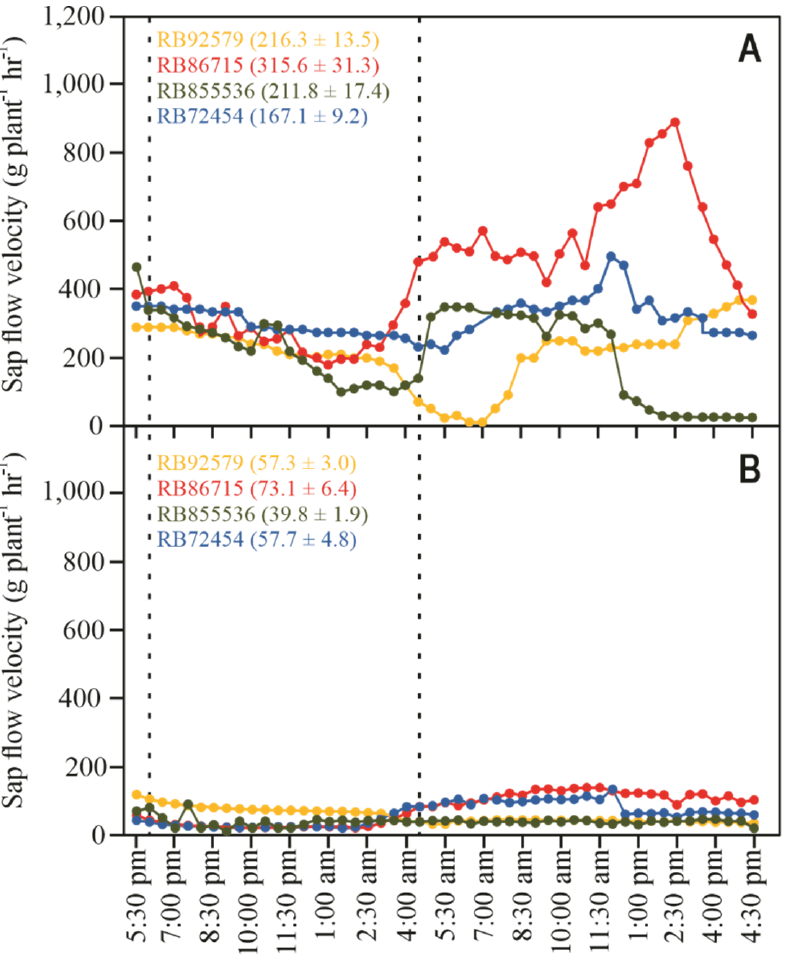
Figure 5. Motive force that drives sap ascent in the xylem (SAP flow velocity) measured over 24 h in open field cultivated sugarcane plants. Each point represents a measurement and the values, in parentheses, represent the average SAP over 24 h (for comparison purposes only), with 49 readings per plant, measured every 30 min. The period of time between the two dotted lines denotes the period of darkness in the coastal region (AL, Brazil). Data in ( A ) were measured in rainy season (2020, July) and data shown in ( B ) were measured in dry season (2020, December).